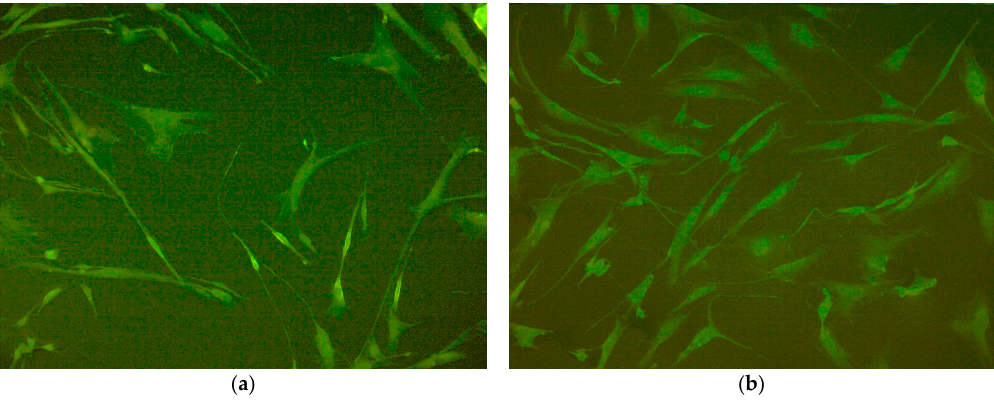
Figure 9. Human dermal fibroblasts on tissue culture polystyrene (TCPS) without magnetic field application ( a ) and in magnetic field ( b ) after 4 days of growth. Magnification ×100, staining of the cell cytoplasm with pyrazolone yellow.